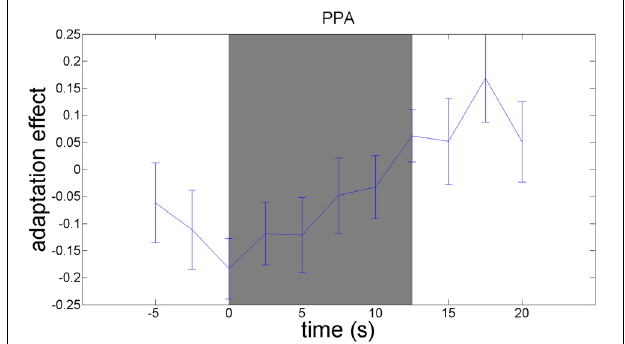
FIGURE 6 | Timecourses of the contrast between the no-adaptation conditions and the material adaptation conditions, in the parahippocampal gyrus. The difference in activation between the no-adaptation blocks and the material adaptation blocks is plotted. Blocks start at 0s and run until 12.5s. The peak of the BOLD-response is delayed 5–6s relative to these times. A material image was shown every